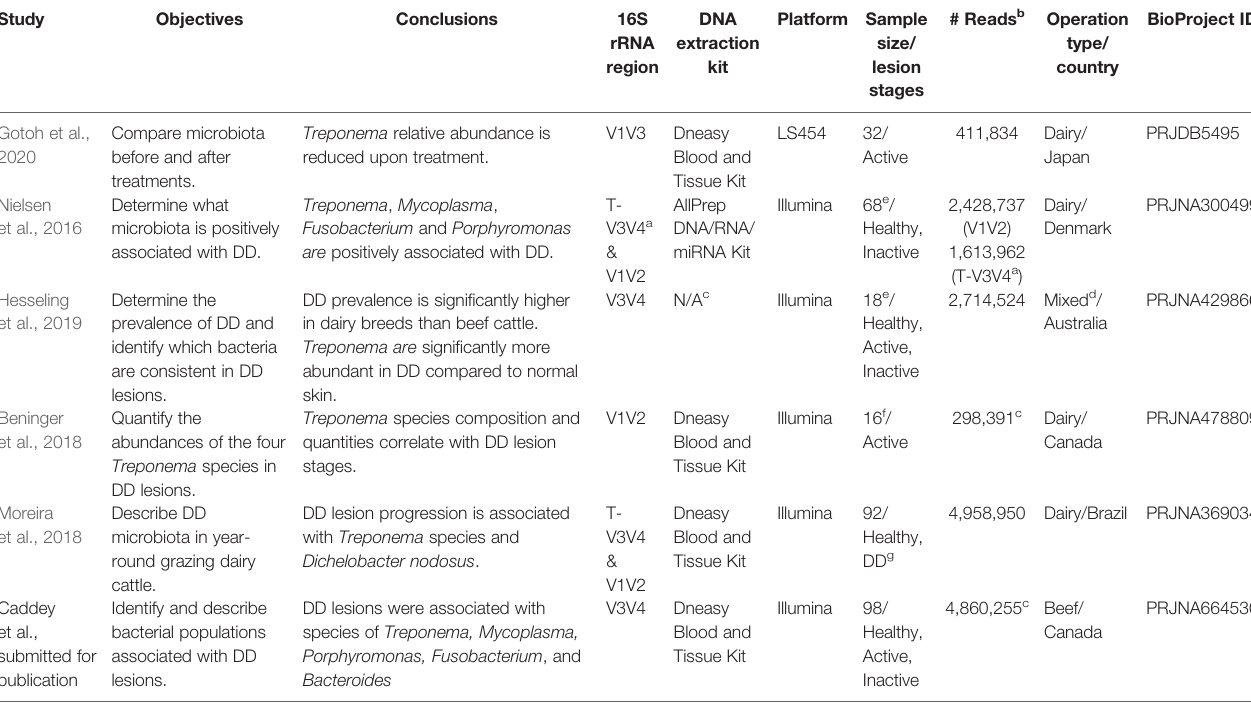
TABLE 1 | Characteristics of studies and sequencing experiments included in